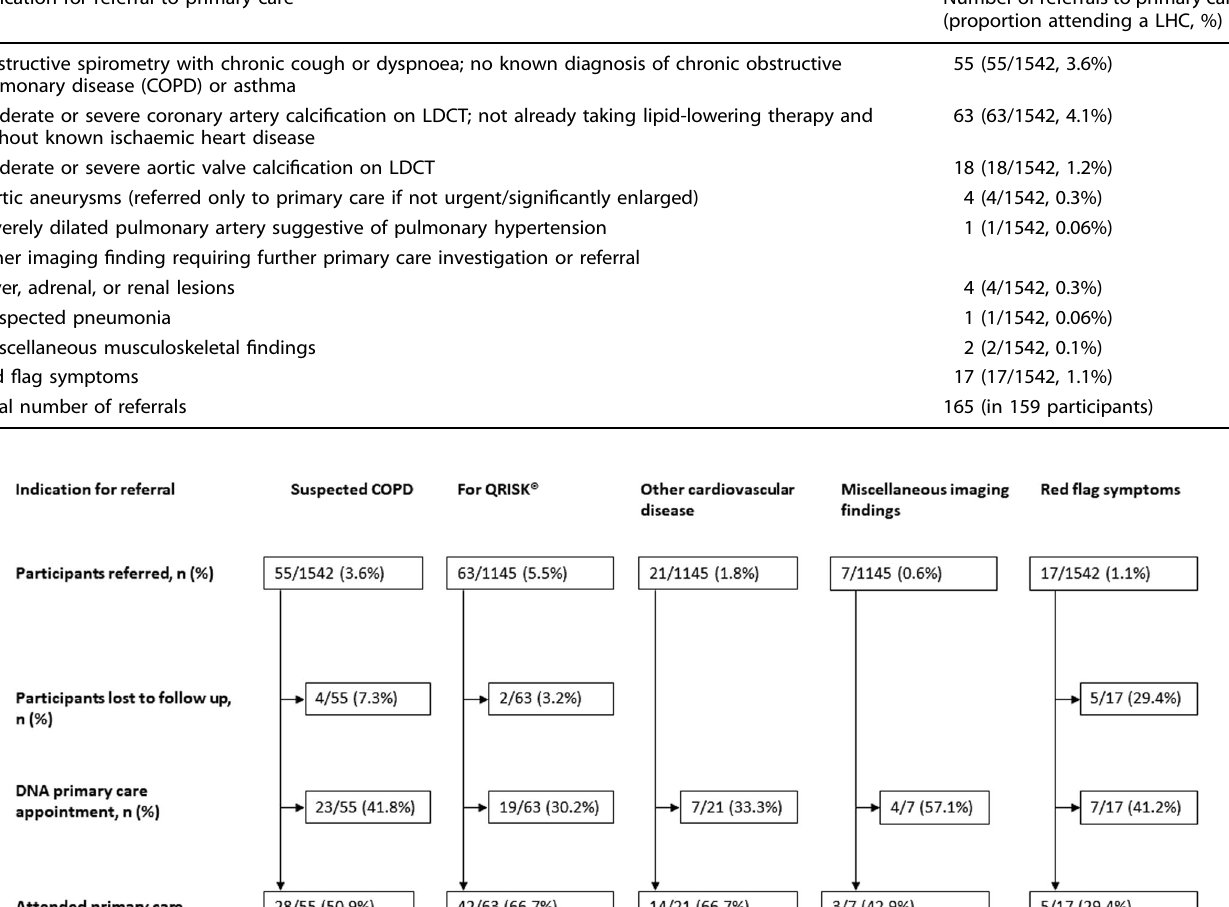
Table 1. Indications for primary care referral in 159 consenting participants from the West London screening pilot. Indication for referral to primary care